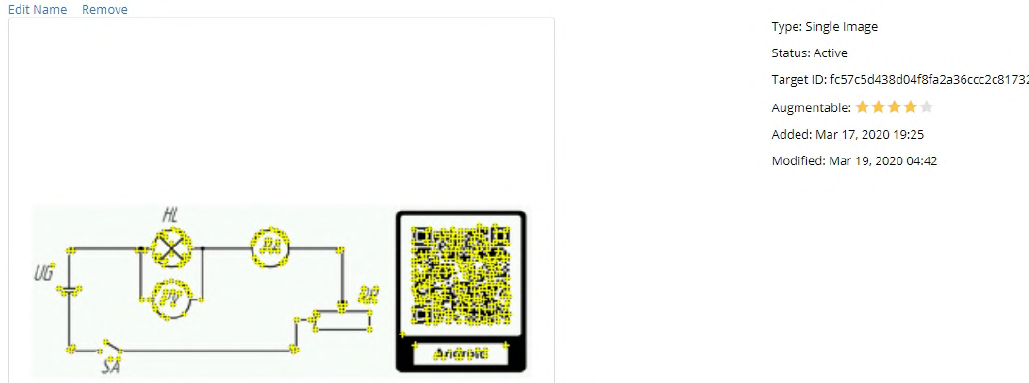
Figure 2: Target image recognition system in Vuforia.